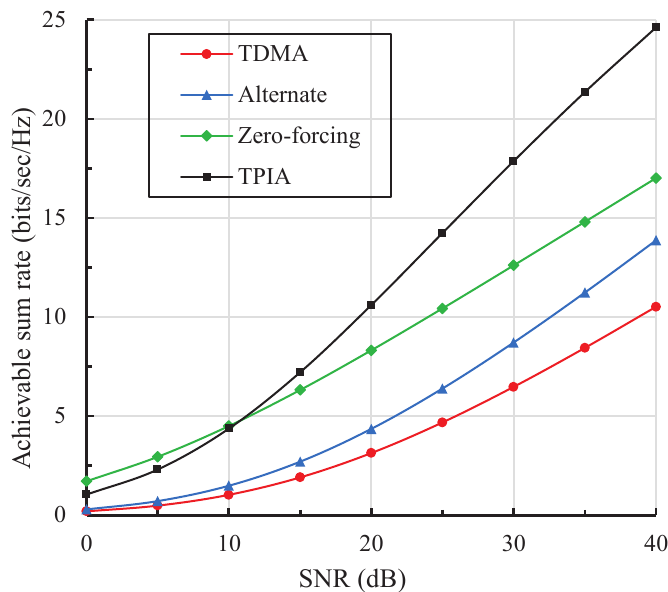
Figure 2. Achievable sum-rate versus signal to noise ratio (SNR) comparison of different schemes.